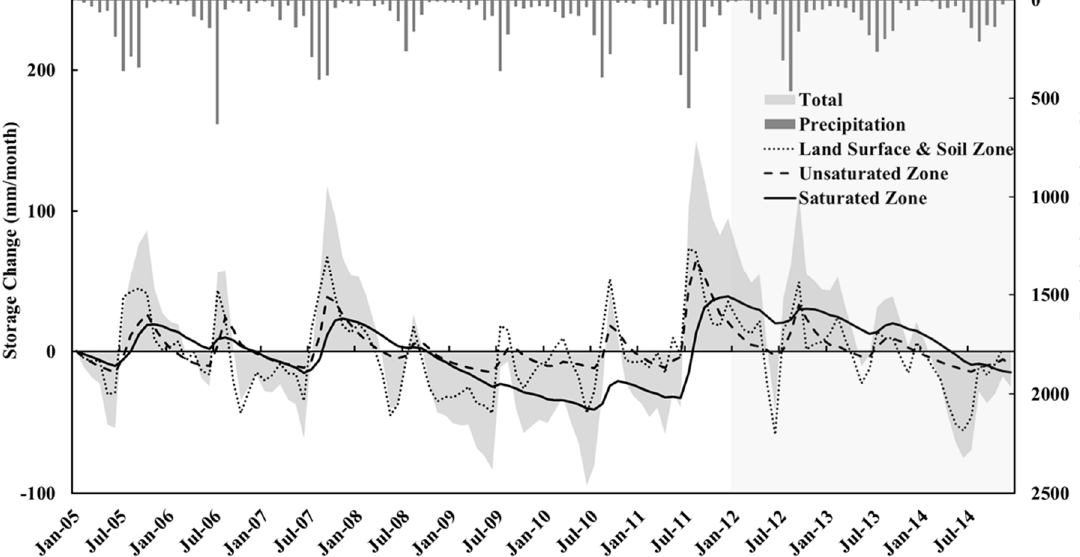
Figure 12. Time series of the monthly storage change in the surface and soil zone, unsaturated zone and saturated zone. Shaded area is the total storage change.